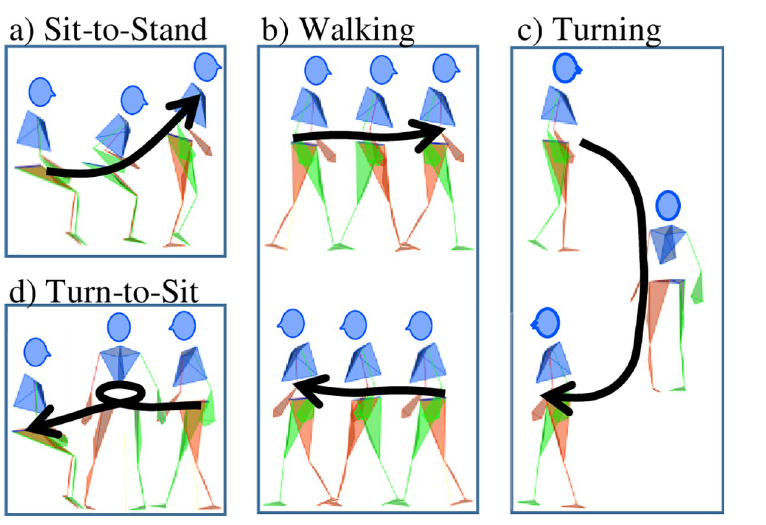
Fig 1. The four phases of the timed-up and go